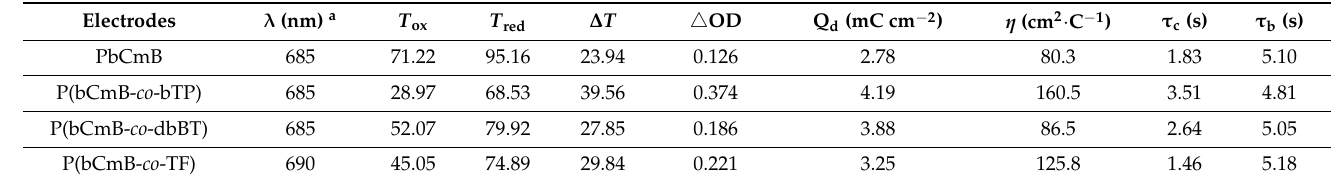
Table 4. Electrochromic switching properties investigated at specific wavelengths for the